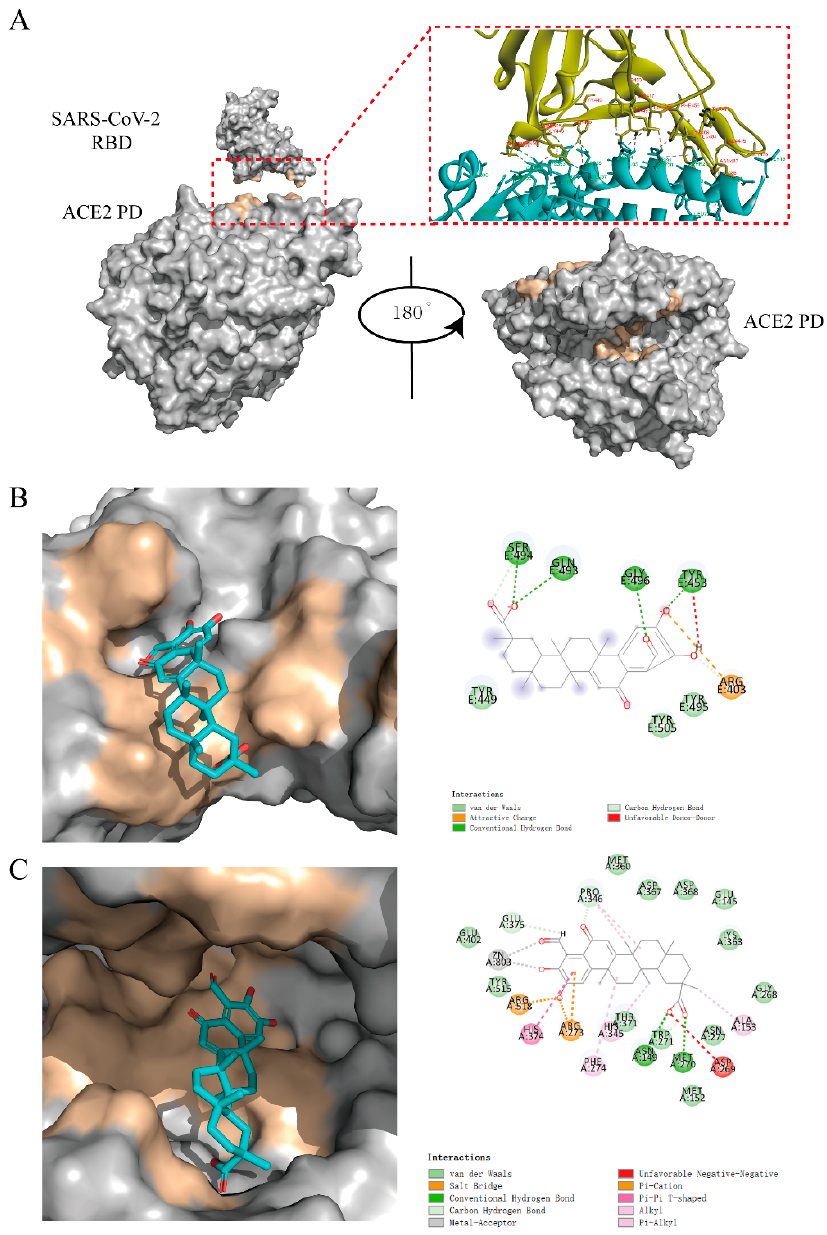
Figure 5. The results of docking. ( A ) Structure of the S-RBD-ACE2 protein–protein interaction (PPI) surface. The S-RBD/ACE2 is shown as a gray molecular surface (PDB ID: 6M0J), with residues that bind to ACE2/RBD colored yellow. The protease domain of ACE2 is shown as a gray molecular surface (PDB ID: 1R4L), with residues that bind to the S-RBD and substrate colored yellow. ACE2 PD (Right) was obtained by rotating ACE2 PD (Left) 180° to the right. ( B ) The interaction between S-RBD and 02B05 (left) and the key amino acids responsible for the interaction (right). ( C ) The interaction between 02B05 and the ACE2 enzyme activity site (left) and the key amino acids responsible for the interaction (right).